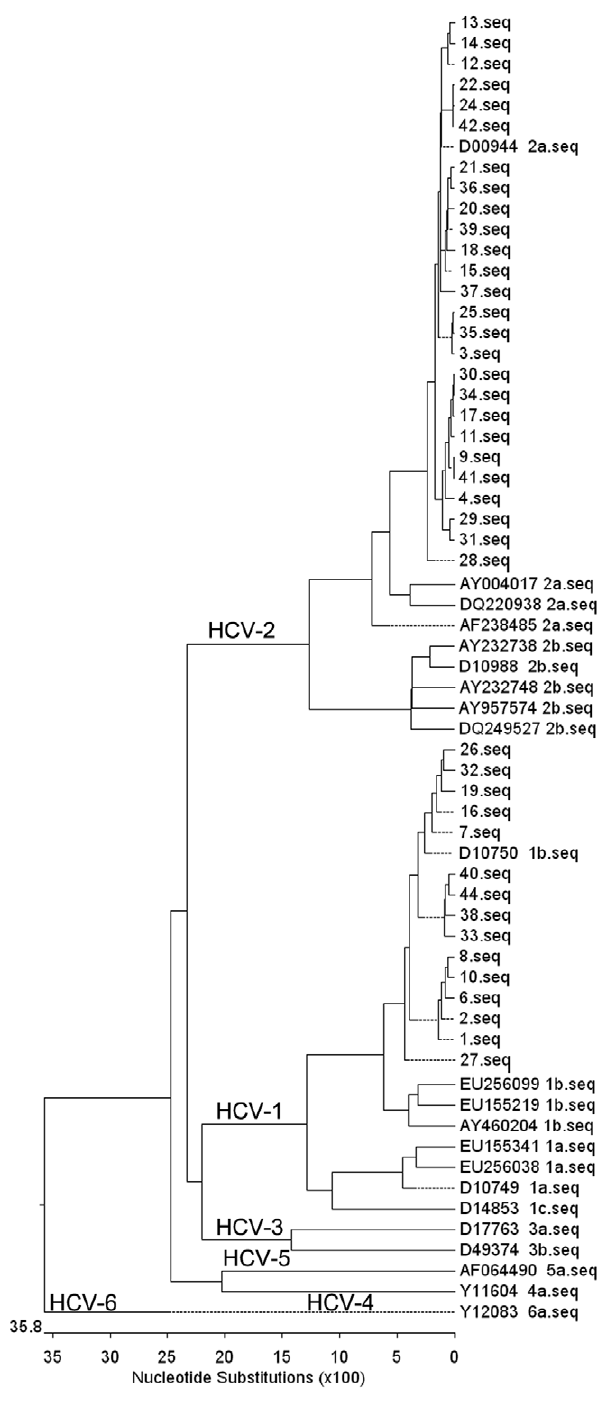
Figure 1. Phylogenetic tree. Phylogenetic tree of the NS5B region constructed with HCV-infected people isolates in Wuwei and reference sequences retrieved from international databases (GenBank). doi:10.1371/journal.pone.0054815.g001 Table 4 shows the differences between the risk factors reported by HCV-positive and HCV-negative participants. Variables not significantly associated with HCV positivity included HBsAg and anti-HBc, blood donation, history of liver disease, gastroscopy and surgical intervention, and use of alcohol. Factors that were